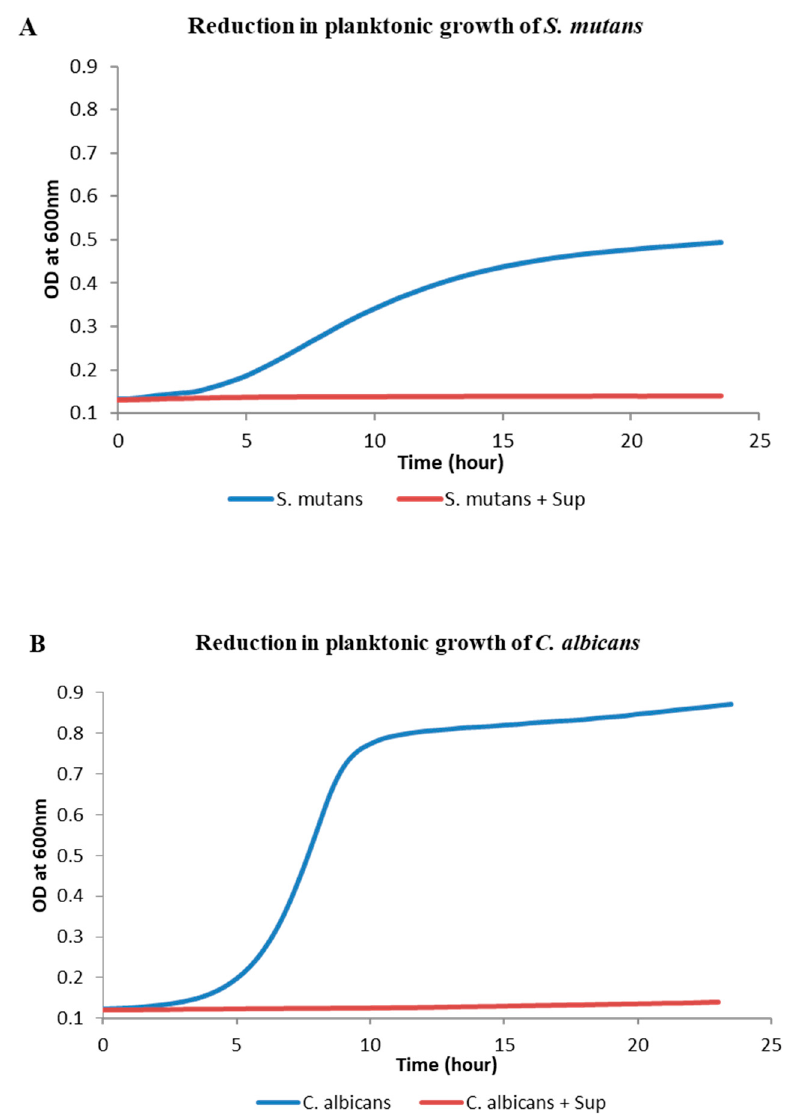
Figure 1. Lactobacillus plantarum 108 supernatant (Sup) inhibited the planktonic growth of S . mutans and C. albicans. S. mutans ( A ) and C. albicans ( B ) growth evaluated using optical density measurements demonstrated a significant inhibition of growth when supplemented with the supernatant.